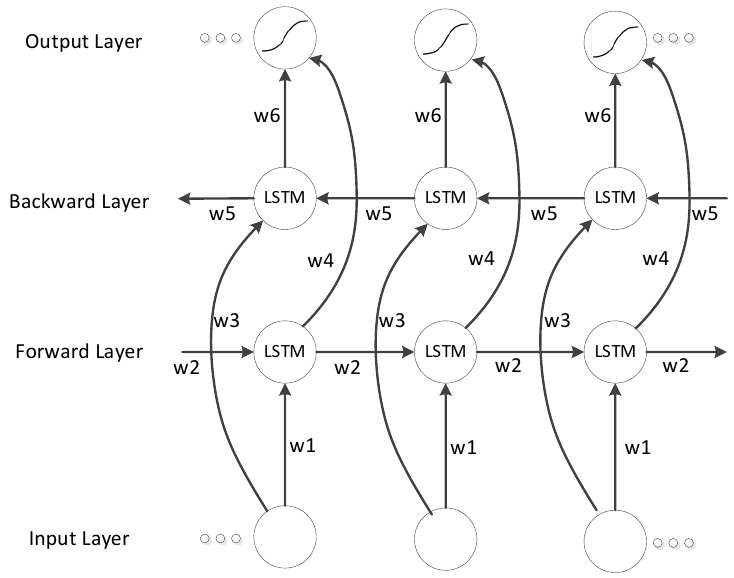
Figure 1. Architecture of the Bi-LSTM model.